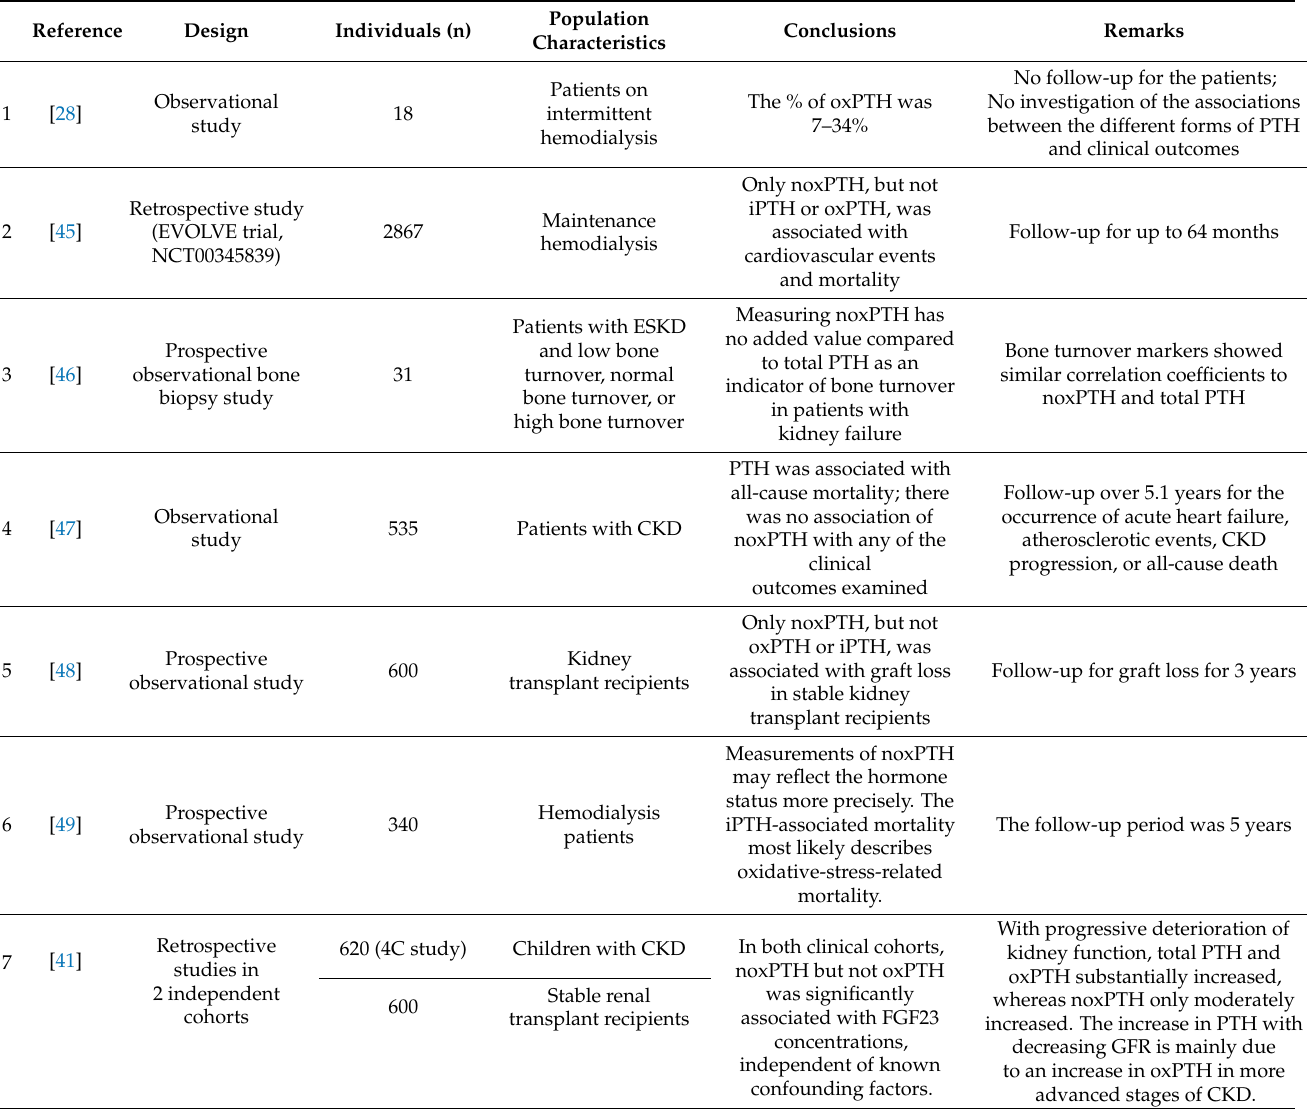
Table 2. Clinical studies on